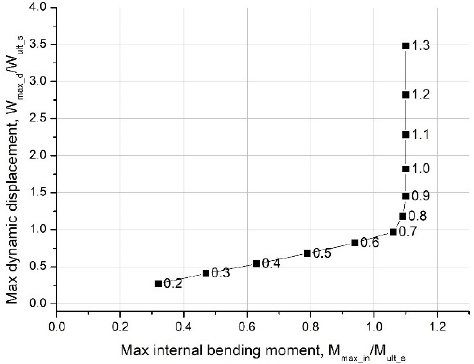
Figure 13. Internal bending moment and vertical displacement for mid-span box girder M2 at load